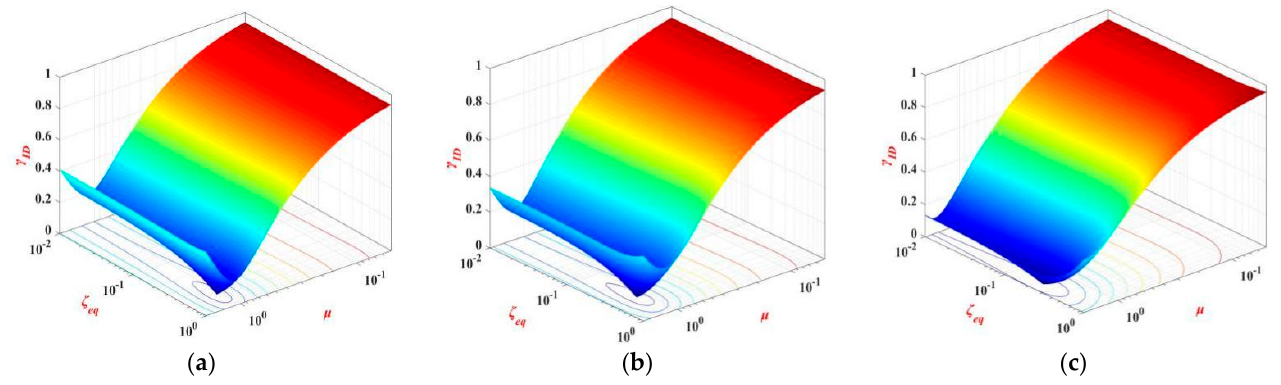
Figure 5. Curves of γ U : ( a ) HB – 1 ; ( b ) HB – 2 ; ( c ) LB–1 ; ( d ) LB–2 .